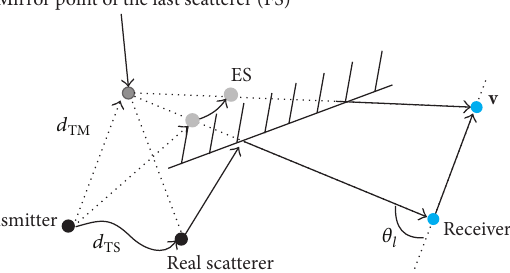
Figure 6: MPC of type M3: example of an ES moving along a hyperbolical trajectory while the FS is fixed during the receiver